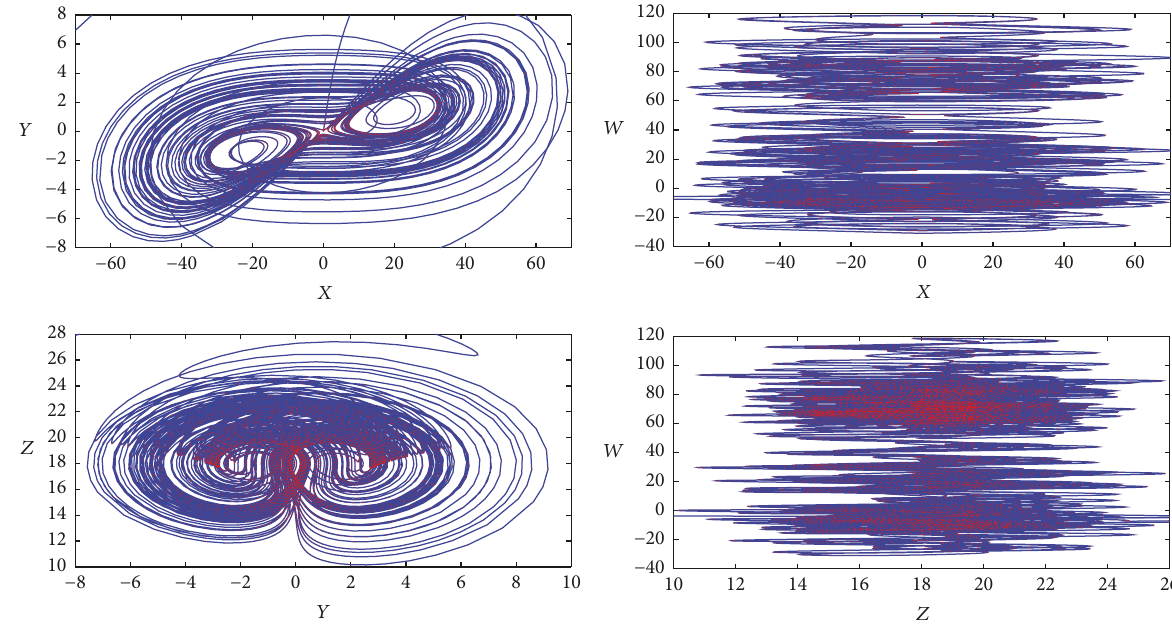
Figure 25: 2D phase portraits of the FPGA implemented FONCS-3 system.